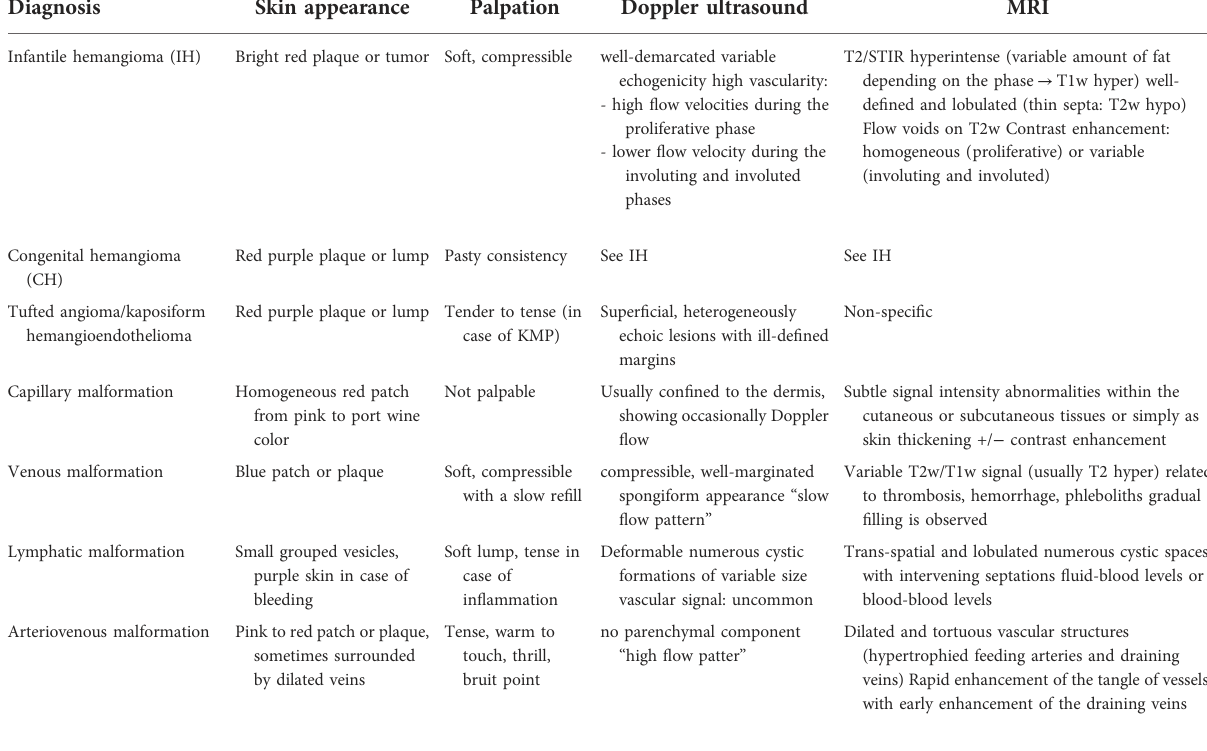
TABLE 1 Clinical and radiological features of the principal vascular